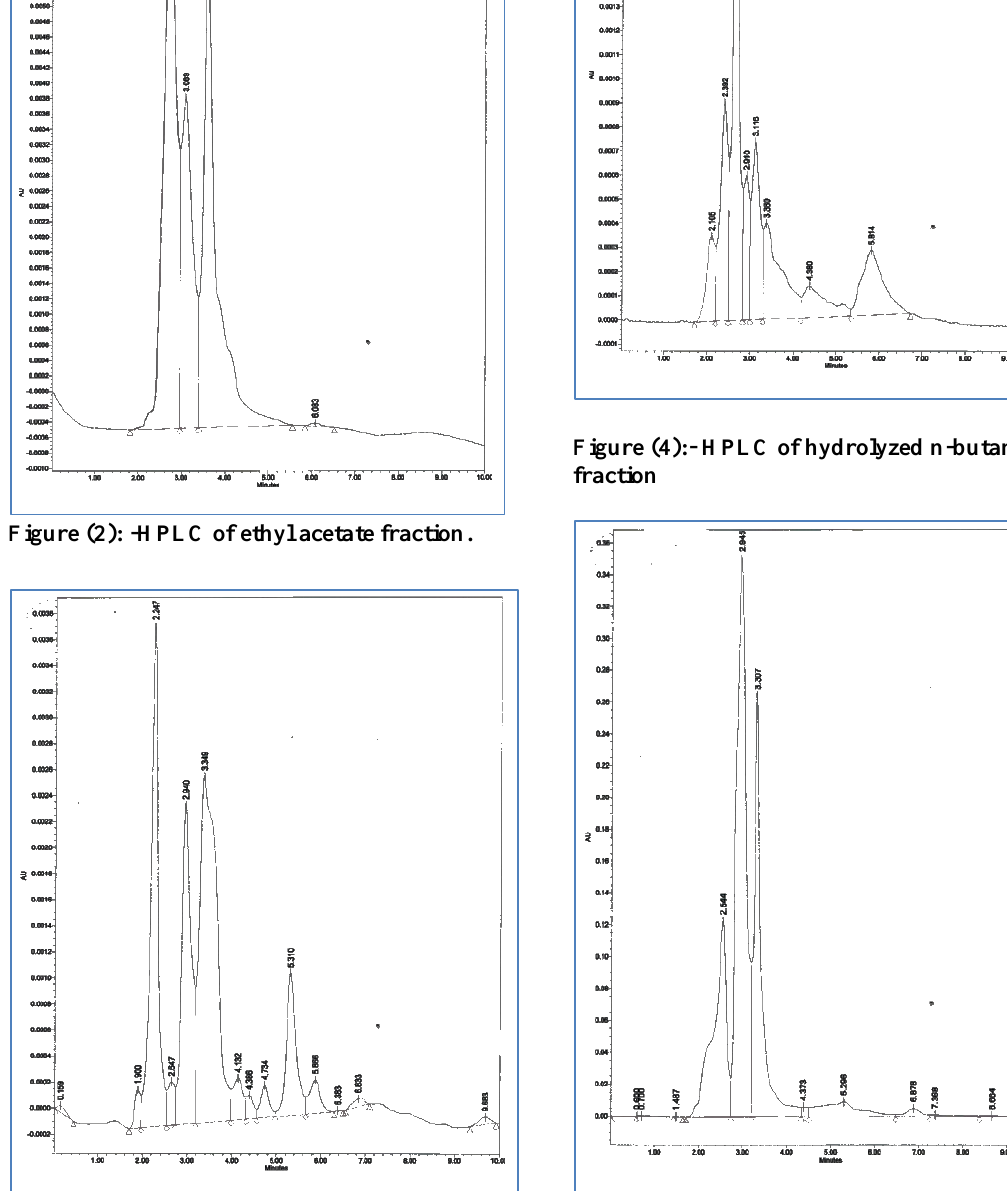
Figure (3):- HPLC of n-butanol fraction.